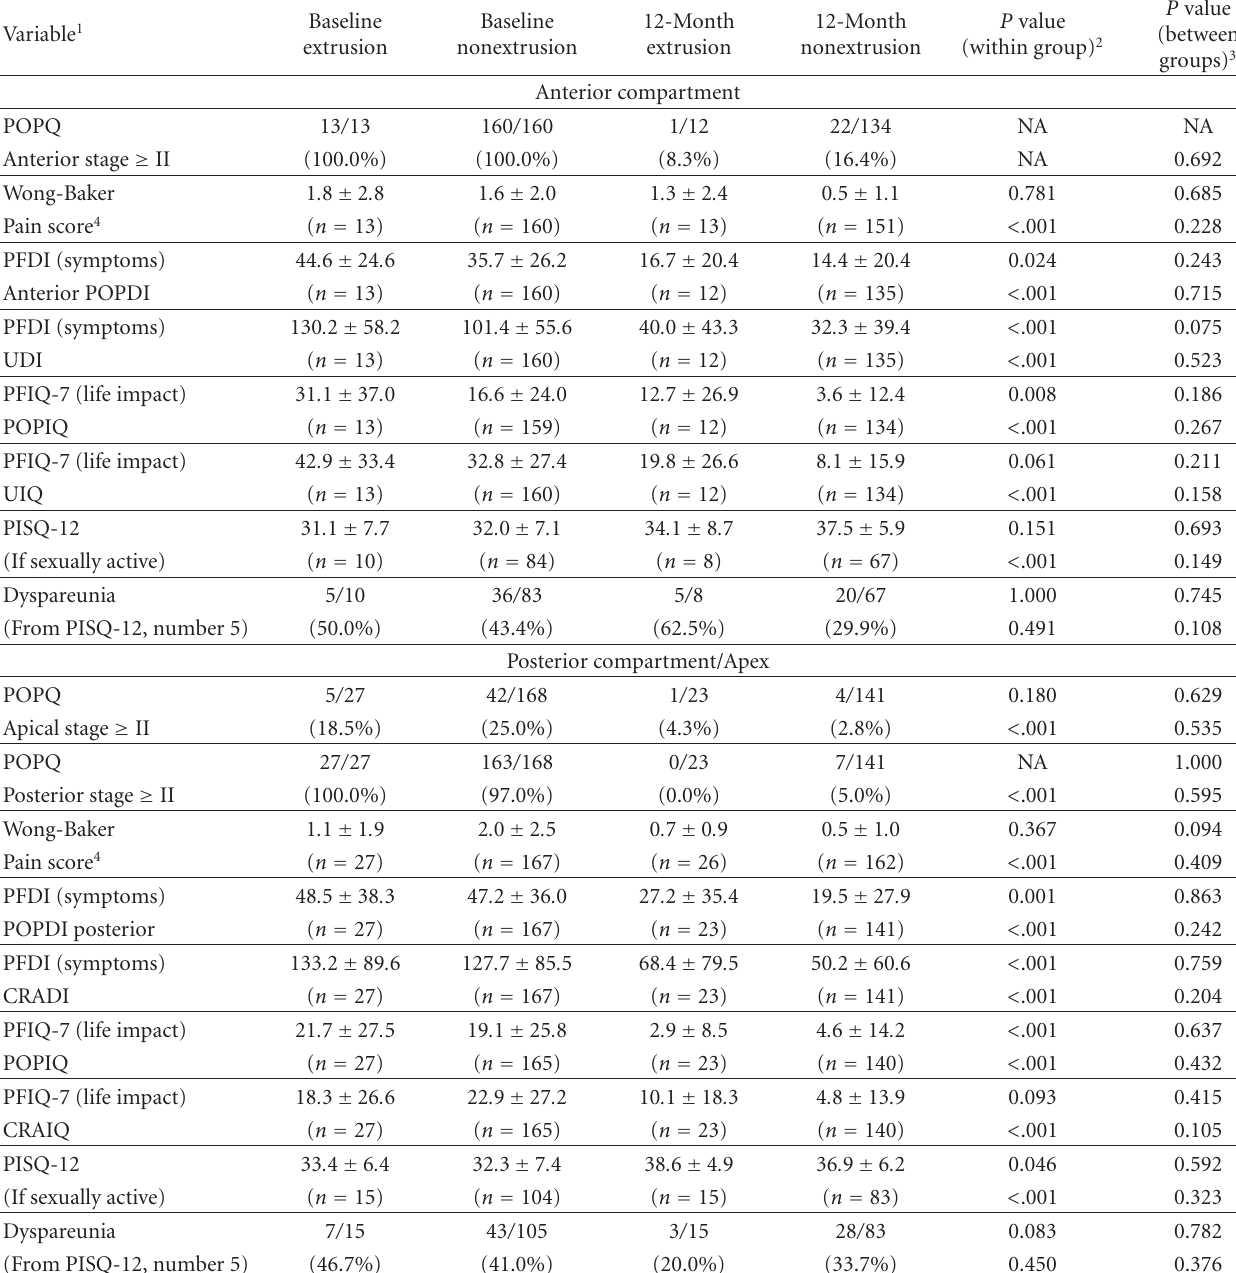
Table 4: Outcome variables for subjects with and without extrusion (AC or